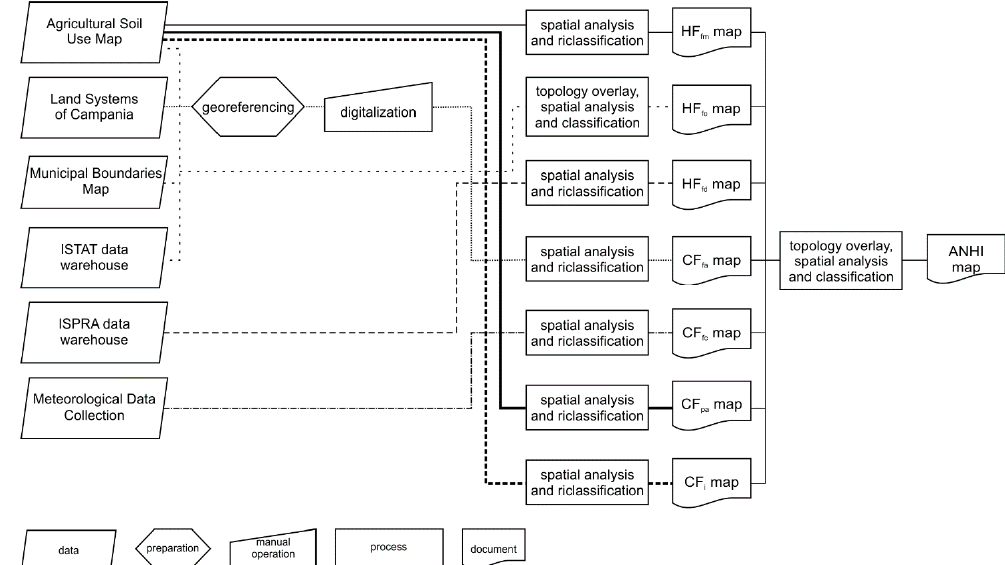
Figure 4. Flow chart of the Geographic Information System realized showing the input data, the analytical processes, and the final map output.